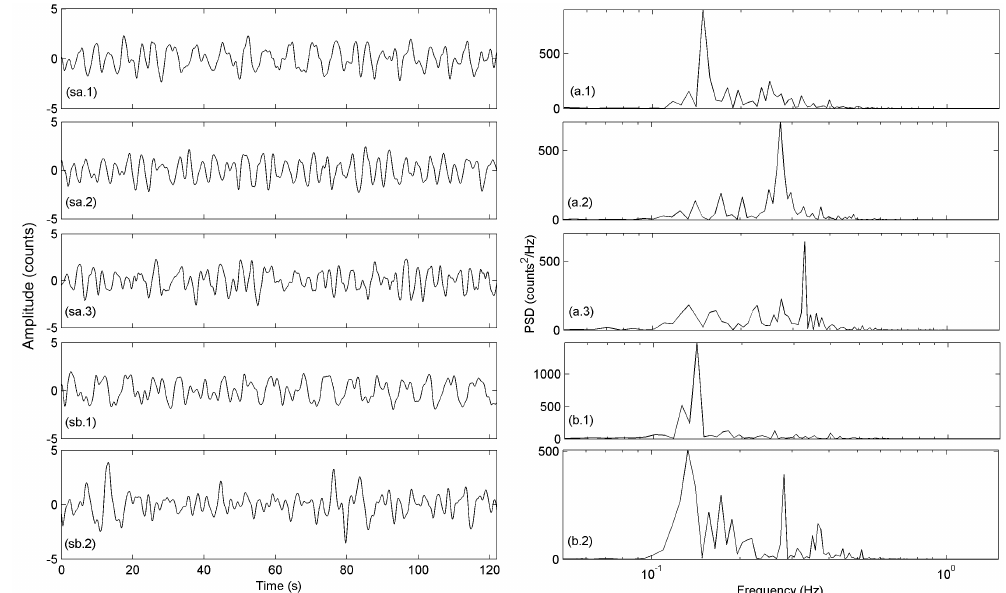
Fig. 7. ICA results in time and frequency domain. The time series extracted in Phase A (sa.1, sa.2, and sa.3) show one quasi-monochromatic peak close to 0.15Hz (a.1), and two close to 0.3 Hz (a.2 and a.3). On the other hand, the waveforms of the two ICs extracted in Phase B (sb.1 and sb.2) display one quasi-monochromatic peak close to 0.15Hz (b.1), and a broad spectrum with two main peaks at about 0.15 Hz and 0.3 Hz (b.2).